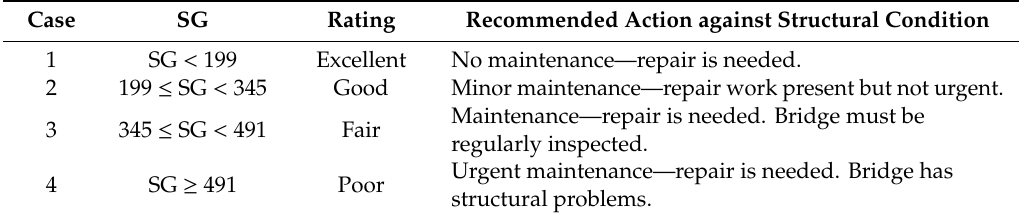
Table 12. Evaluation of river bridges in terms of structure grade